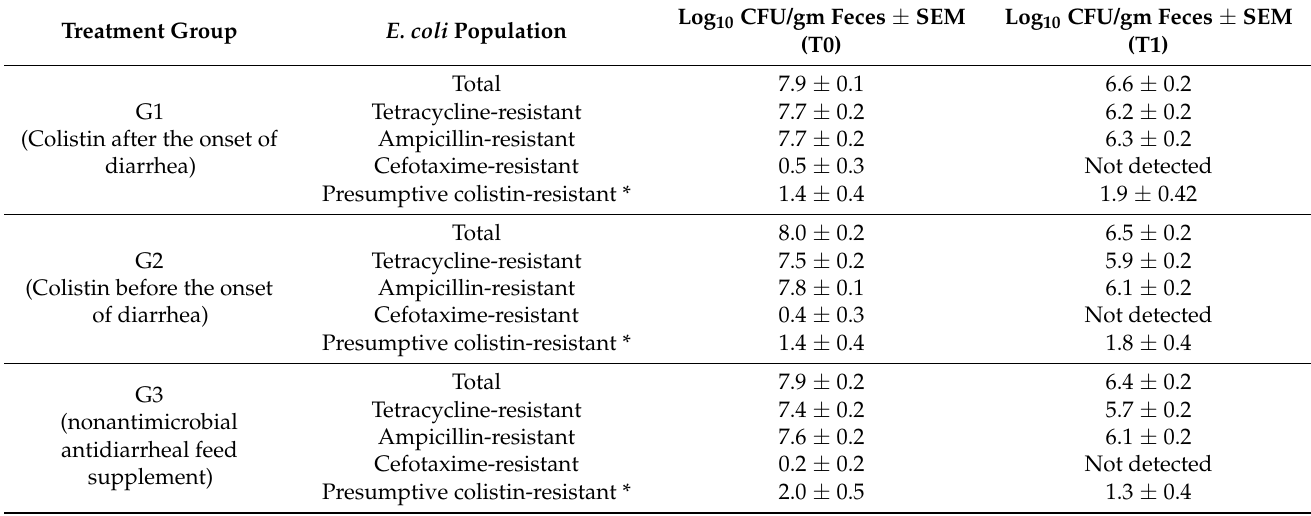
Table 1. Analysis of the E. coli population in the different treatment